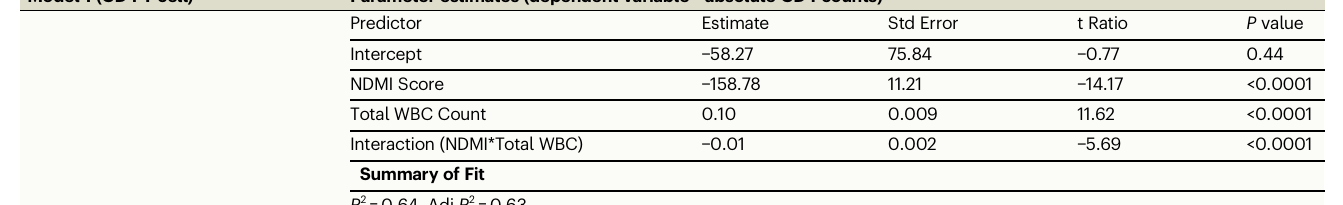
Table 2 | Neutrophil dexamethasone methylation index (NDMI) scores predict CD4 T and mMDSC cell counts in Immune Pro fi les Study glioma patients with presurgery samples a Model 1 (CD4 T